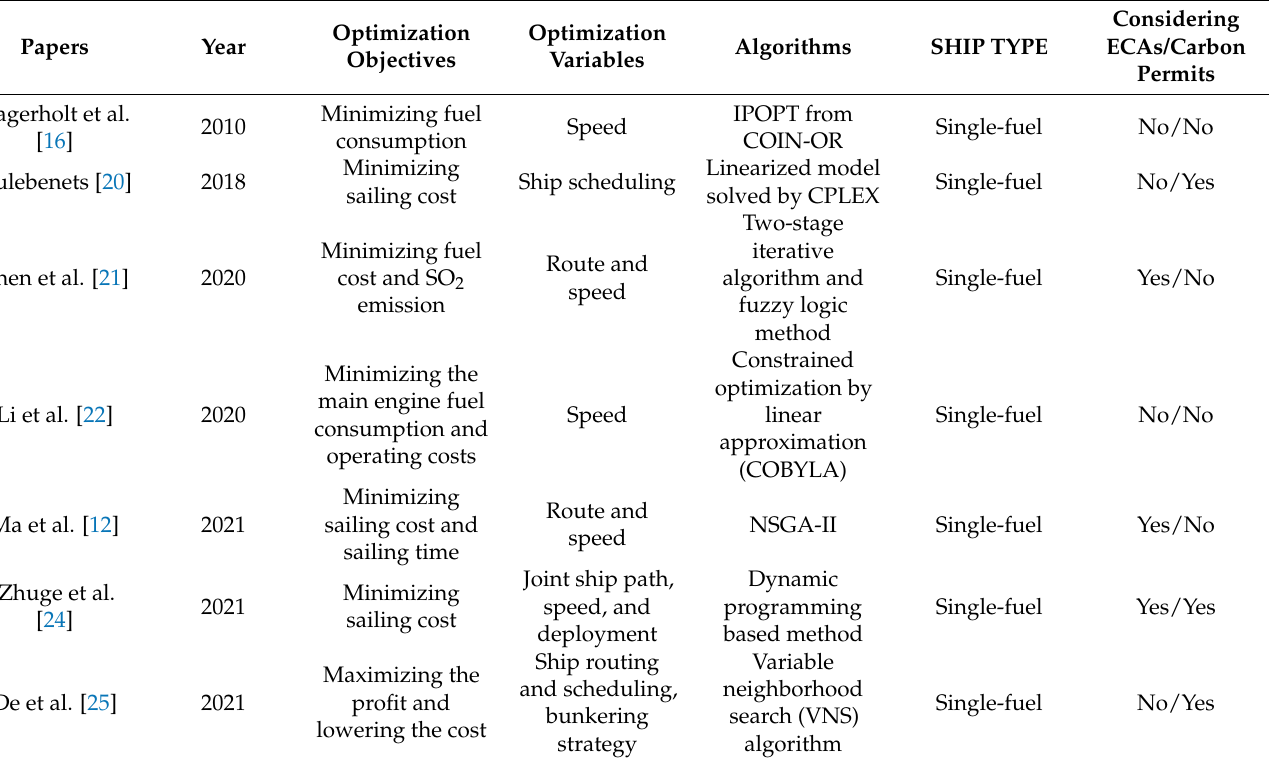
Table 1. Sample of operation optimization papers and the objectives, variables, algorithms, ship types, and considered regulations in those